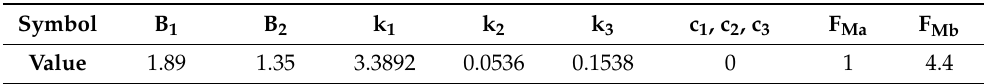
Table 4. The bare module cost constant factor of the